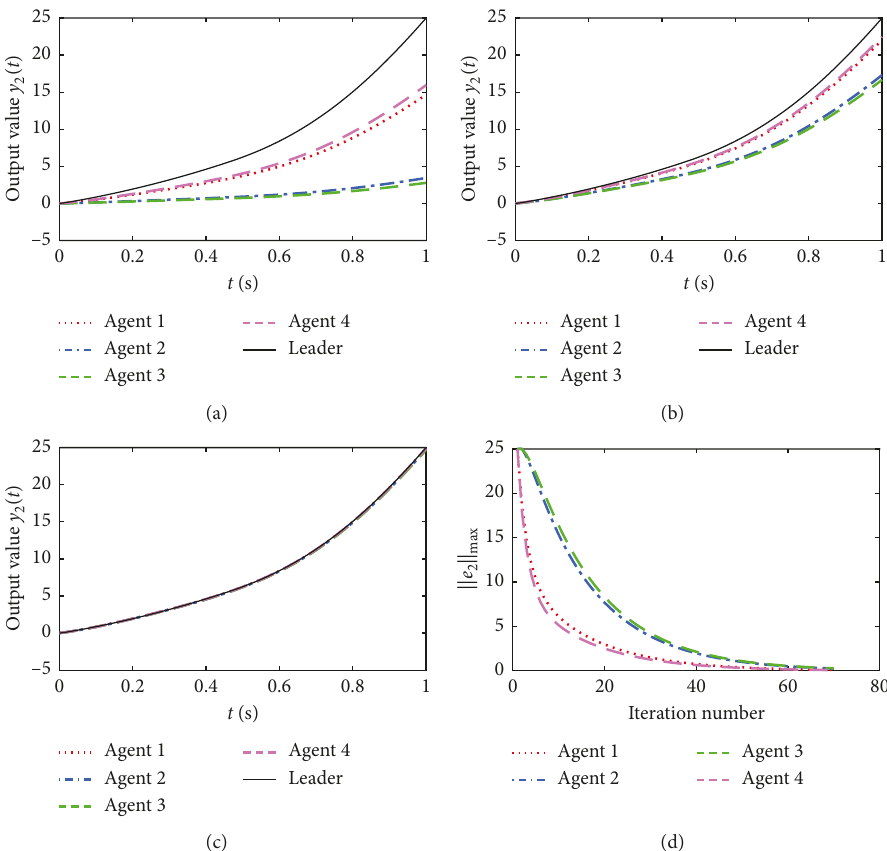
Figure 5: Results of y D α -type FOILC. (a) Trajectories y 2 with open-loop 2 ( t ) at the 5th iteration. (b) Trajectories y 2 ( t ) at the 20th iteration. (c) Trajectories y 2 ( t ) at the 70th iteration. (d) Tracking error e 2 vs. iteration number.